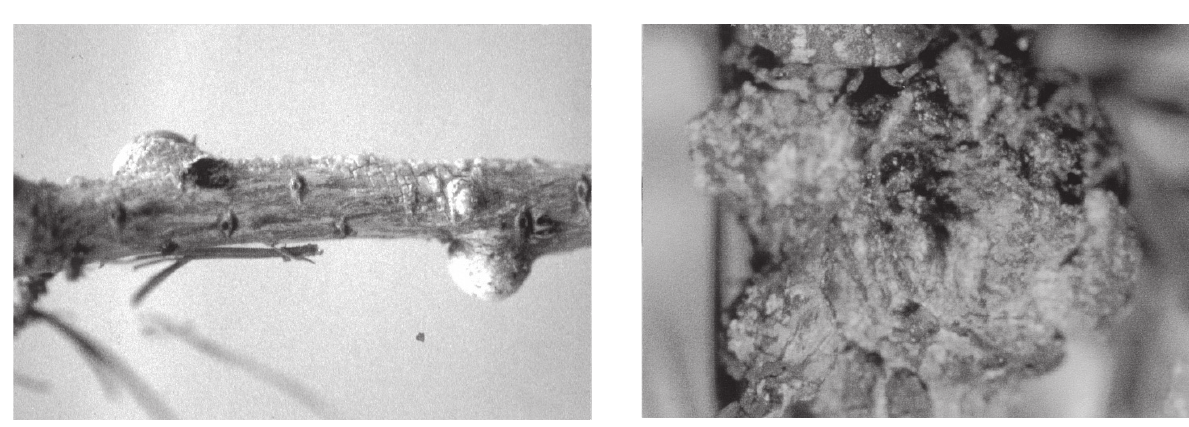
Fig. 2. A 2-year-old Aleppo pine twig with small knots. Fig. 3. A 3-year-old Aleppo pine twig with large, ligni fi ed and suberised